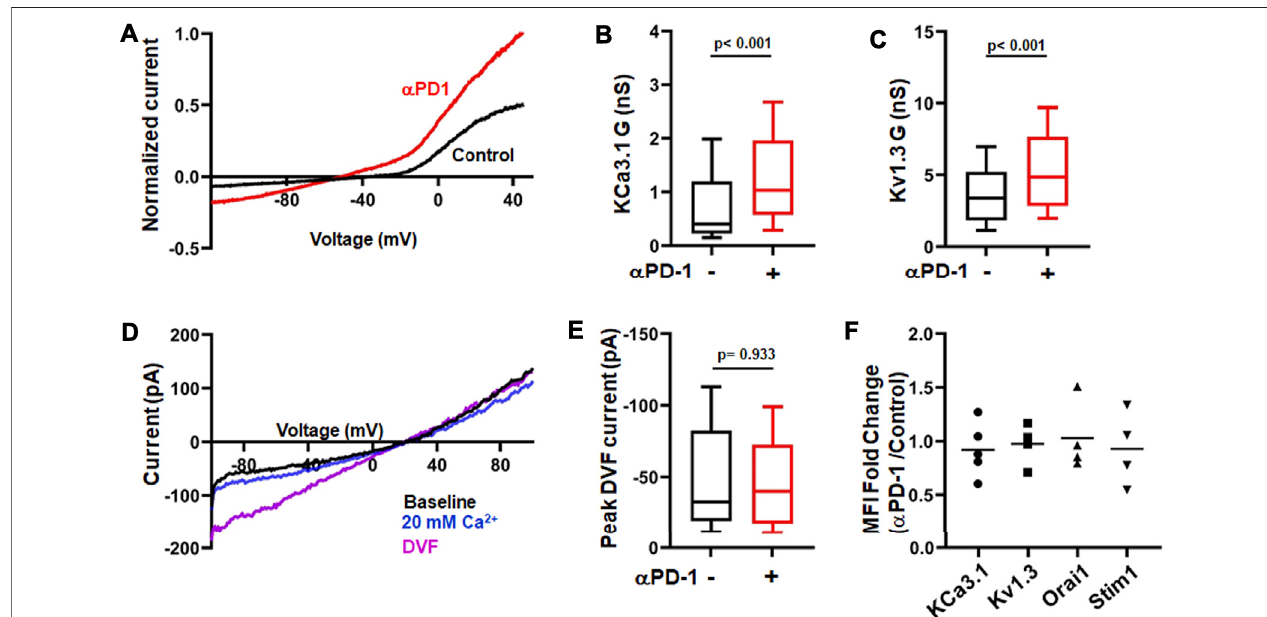
FIGURE 1 | α PD-1 treatment increases K + channel activity in HNSCC T cells. (A) Representative current traces of KCa3.1 and Kv1.3 channels recorded in whole- cellmodeofvoltage-clampcon fi gurationinactivatedCD8 + PBTscellsfromaHNSCCpatientinabsenceorpresenceof α PD-1(10 μ g/ml,for6